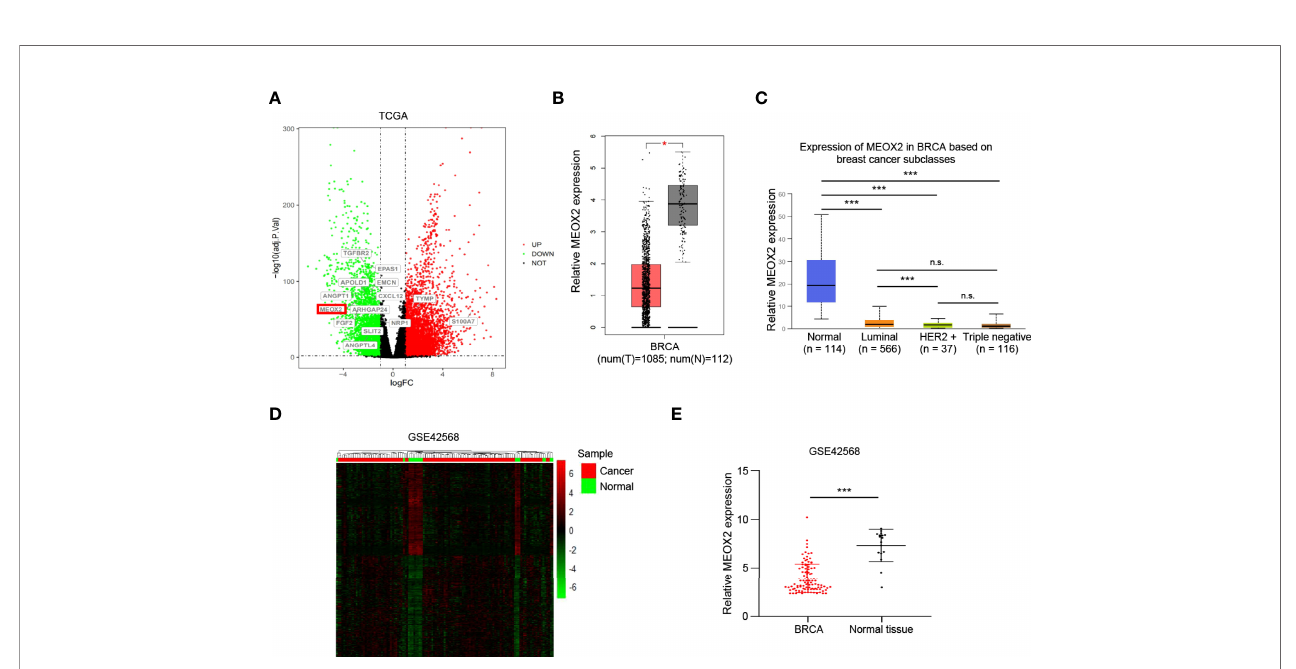
FIGURE 1 | The differentially expressed genes between the healthy controls and the breast cancer patients. (A) The volcano plot presents all angiogenesis-related differentially expressed genes in the TCGA dataset (false discovery rate (FDR) <0.05, |log2 fold change (FC)| > 1) (red dots, up-regulated genes; green dots, down- regulated genes). (B, C) The MEOX2 gene expression pro fi le across tumor samples and paired normal tissues from the TCGA dataset analyzed with Gene Expression Pro fi ling Interactive Analysis (GEPIA) and the expression in subtype groups analyzed with UALCAN. (D) The heat map indicates the differentially expressed genes between the cancer and normal cells in the GEO dataset GSE42568. Each row or column represents one gene or sample, respectively. Green and red bars represent decreased or increased gene expression, respectively. (E) Expression of MEOX2 in breast cancer and normal breast tissues in the GEO dataset GSE42568. *p < 0.05, ***p < 0.001, and ns indicated no signi fi